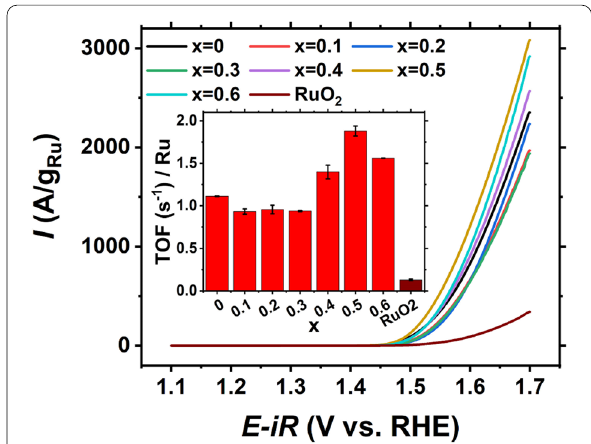
Fig. 5 Polarization curves of YMRO-x and reference RuO 2 electrocatalysts, the inset shows the comparison of TOF at 1.60 V versus RHE for YMRO-x and RuO 2